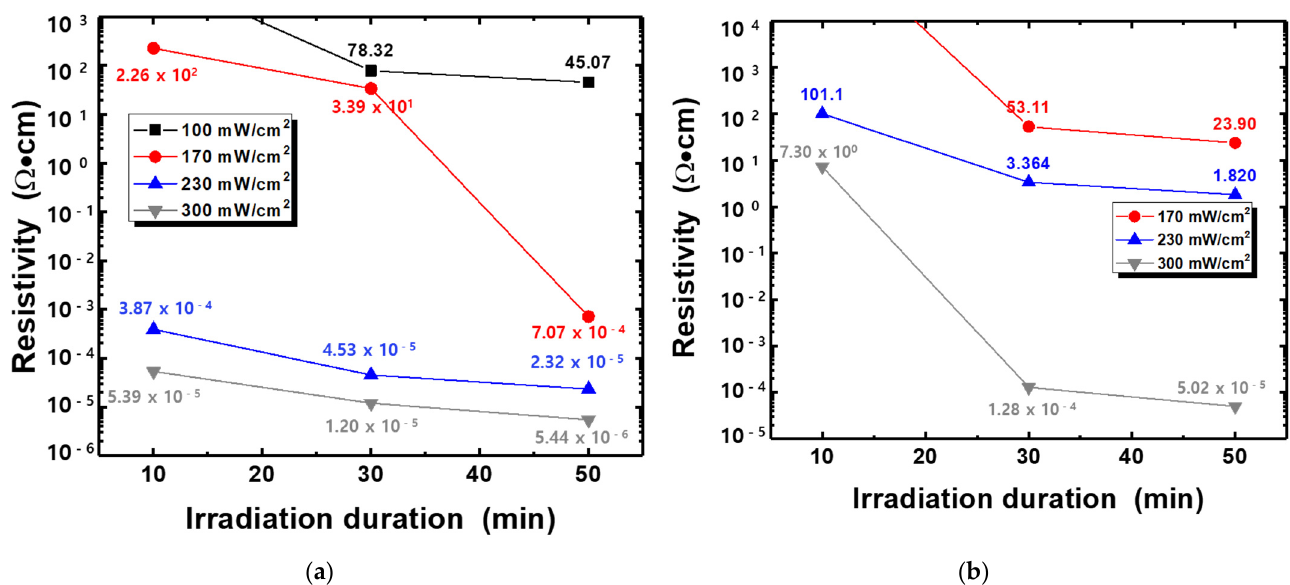
Figure 10. Dependence of the light intensity and irradiation duration of UV-LED module on the electrical resistivity of Ag films: ( a ) 365 nm, ( b ) 385 nm.